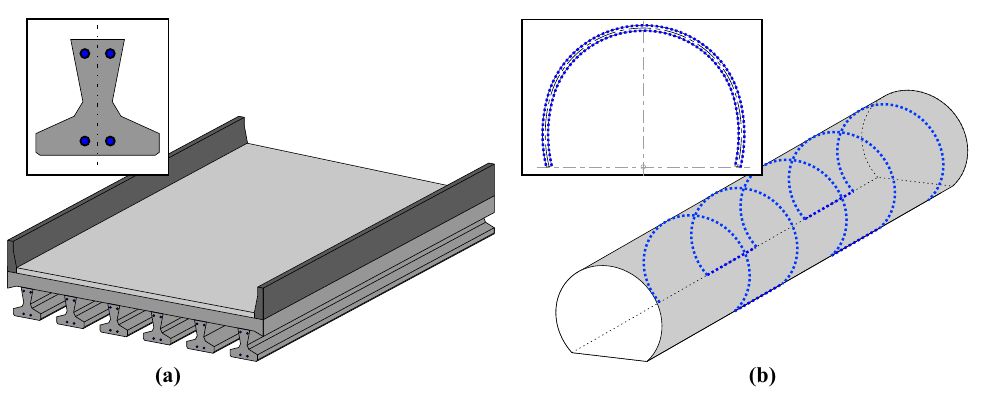
Figure 22. Seminal applications for distributed fiber optic shape sensing in civil structural health monitoring: ( a ) Bridge beams. ( b ) Tunnel cross